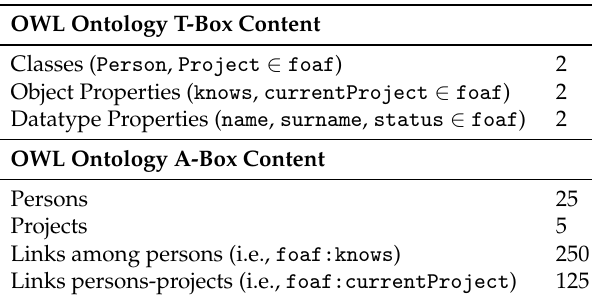
Table 1. Use Case #1: Summary of the knowledge base.